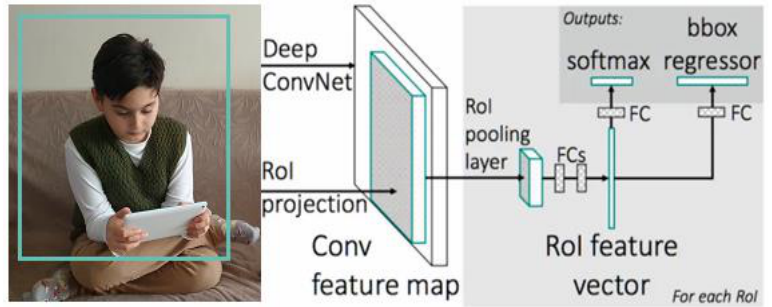
Fig. 2. Illustration of the CNN.